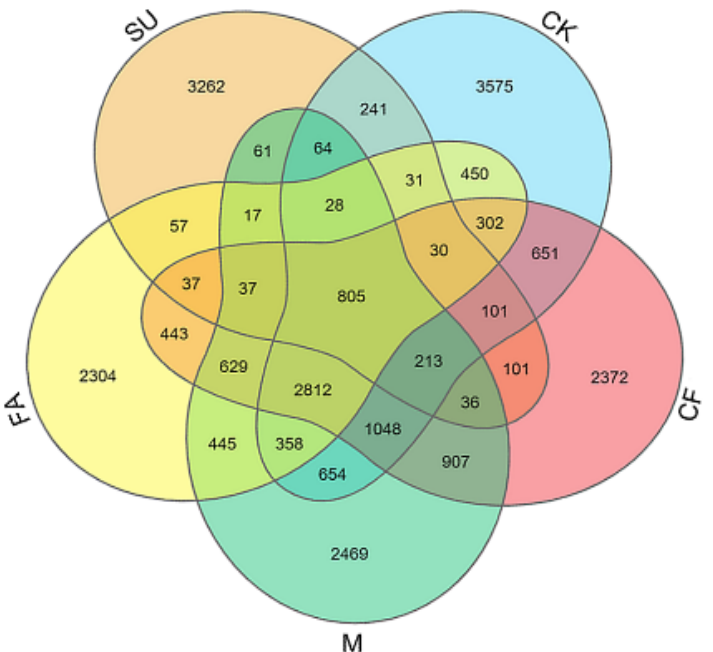
Figure 1. OTU Venn analysis of different treatments. OTU: Operational Taxonomic Units; CK: reclaimed soil sampled in no-fertilizer treatment; CF: reclaimed soil sampled in chemical fertilizer treatment; M: reclaimed soil sampled in manure treatment. SU: subsided soil sampled in an adjacent site; FA: soil sampled in another adjacent farmland. Table 2. Estimated number of observed Sobs, coverage, richness, and diversity in different treat- ments.